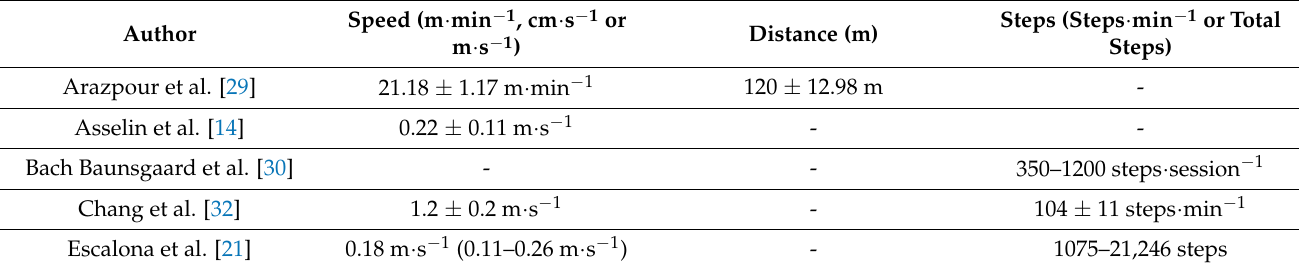
Table 5. Mean walking speed (m · min − 1 , cm · s − 1 or m · s − 1 ), distance (m) and steps (steps · min − 1 or total steps).